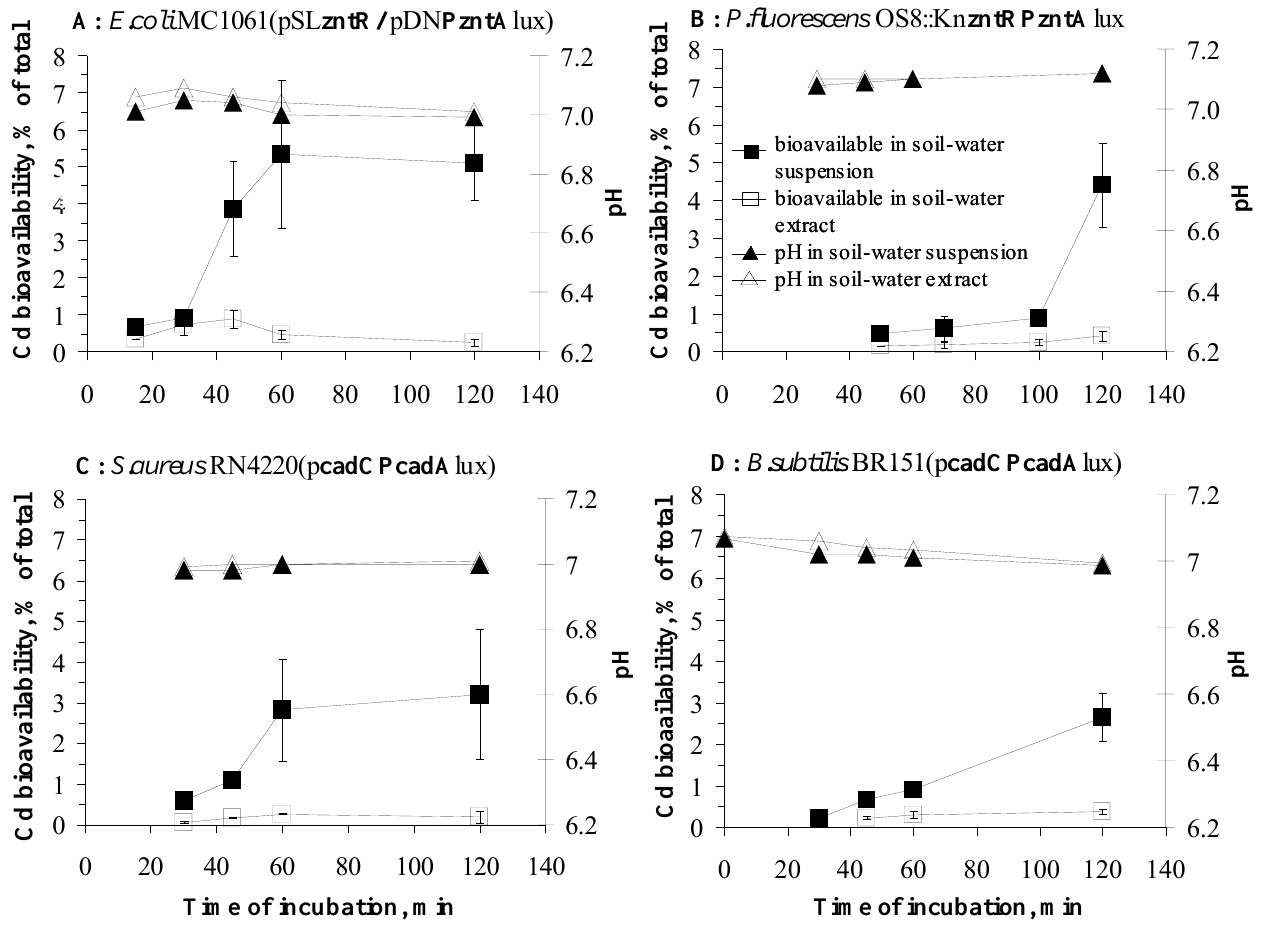
Figure 4 . Bioavailability of Cd in water suspensions and the respective extracts of Cd-spiked soils to different recombinant sensor bacteria during 2-hour incubation. Bioavailability of Cd in soil-water suspension ( ) or soil-water extract ( ) determined by different sensor bacterial strains (A-D). pH in soil-water suspension ( ) or extract ( ) during 2-hour incubation is presented. A: E.coli MC1061(pSL zntR/ pDN PzntA lux) B: P.fluorescens OS8::Kn zntRPzntA lux